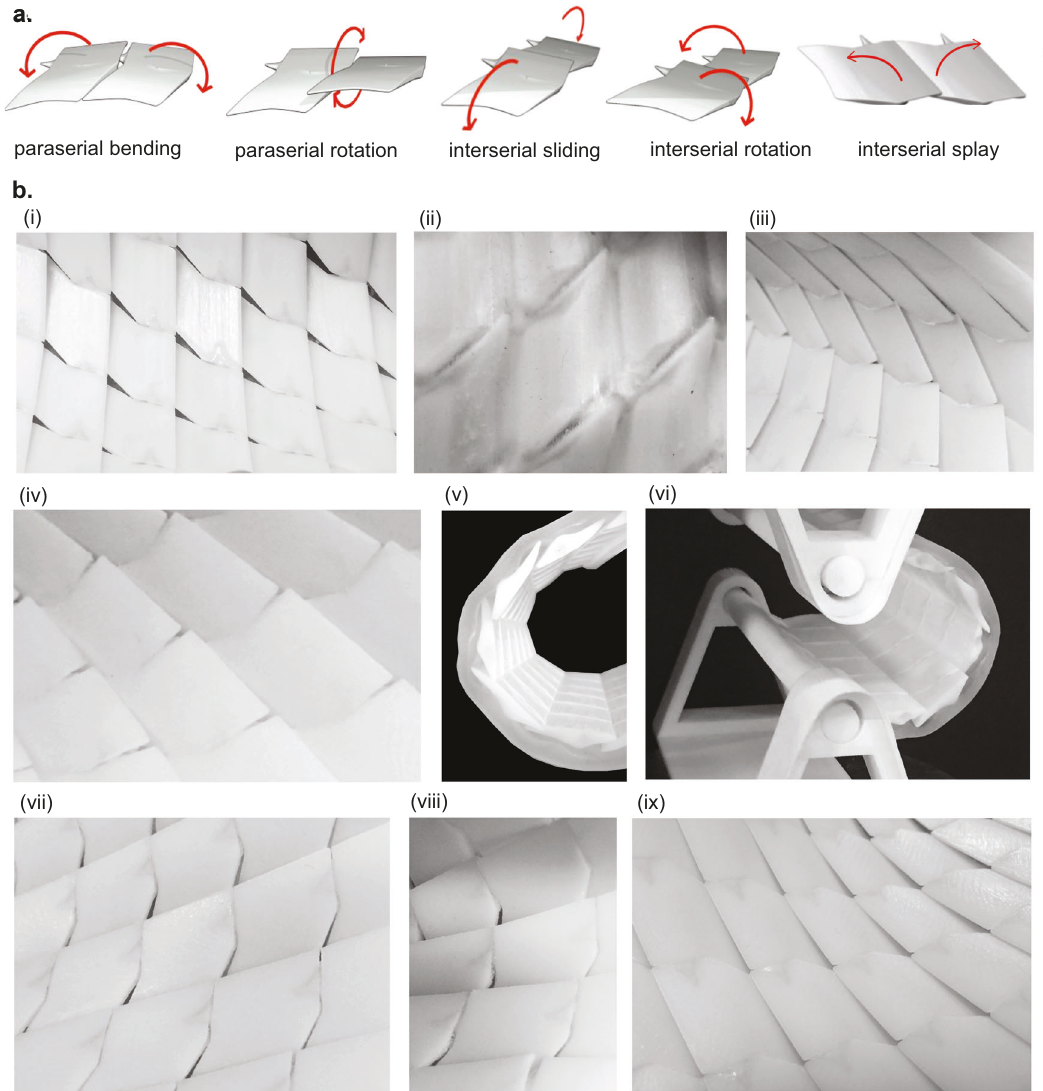
Fig. 6 Orientation-dependent bending behavior of the scaled prototypes. a Schematics of the six interscale mobility mechanisms observed during bending. b Experimental bending of the prototype with (i) φ = 0°. Paraserial bending at vertical displacement ( d ) = 3 mm and (ii) back view of sample showing anterior process pushing into the substrate at d = 15 mm. (iii) φ = 30°. Paraserial rotation at d = 15 mm. (iv) φ = 60°. Paraserial and interserial rotation at d = 50 mm. (v) φ = 90°. Interserial sliding at d = 15 mm, side view and (vi) further interserial sliding after interserial contacts at d = 60 mm (side view). (vii) φ = 120°. Paraserial and interserial rotations and (viii) interscale contacts at d = 20 mm. (ix) φ = 150. Paraserial and interserial rotations plus interserial splay at d = 14